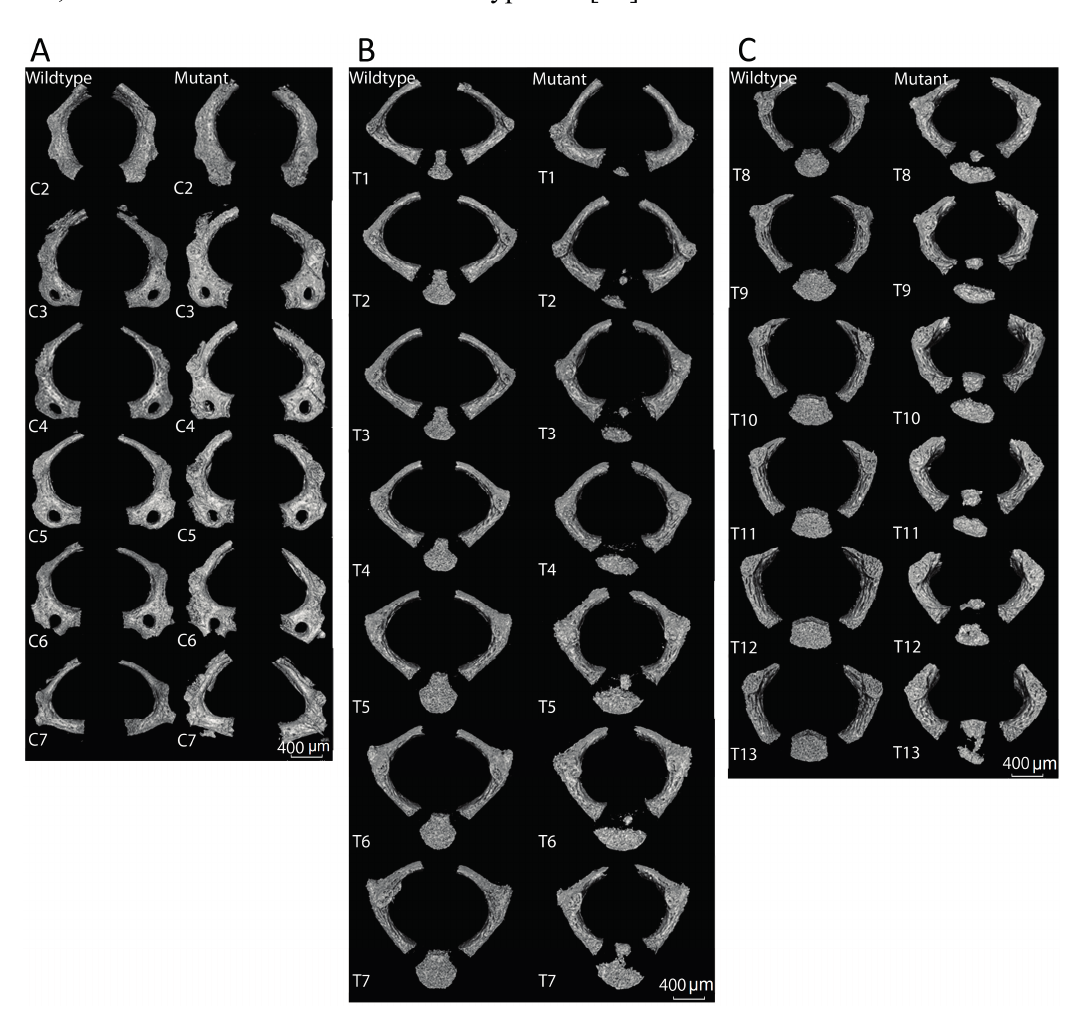
Figure 3. Pairwise comparison of shape and size of individual vertebrae. ( A ) Cervical vertebrae C2 through C7. ( B ) Thoracic vertebrae T1 through T7. ( C ) Thoracic vertebrae T8 through T13. Differences in shape and surface characteristics were apparent. Vertebral bodies of T8-T11 were less mineralized in the Col11a1-deficient mouse compared to WT. Vertebral bodies in WT mouse in comparison to Col11a1-deficient mouse show evidence of hemi-vertebrae malformation with decreased mineralization along the midline of the vertebra. Scale bar A–C = 400